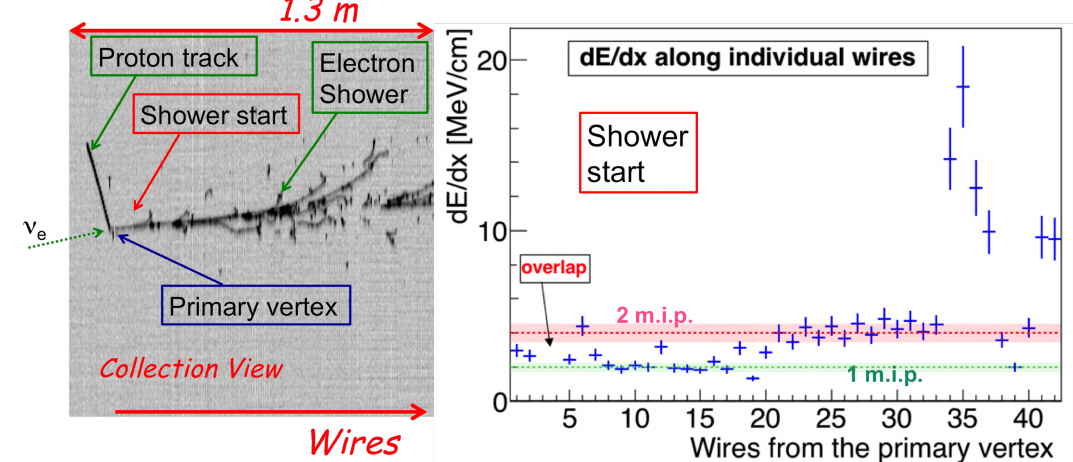
Figure 2. Zoom view of the interaction vertex of an atmospheric electron neutrino event with a deposited energy of 2.12 GeV (left). The evolution of the ionization density dE/dxin the first wires of the shower is also shown (right), providing a clear signature for the electron identification. A proton track (115 MeV) has been also identified studying the dE/dx versus range relation [13].